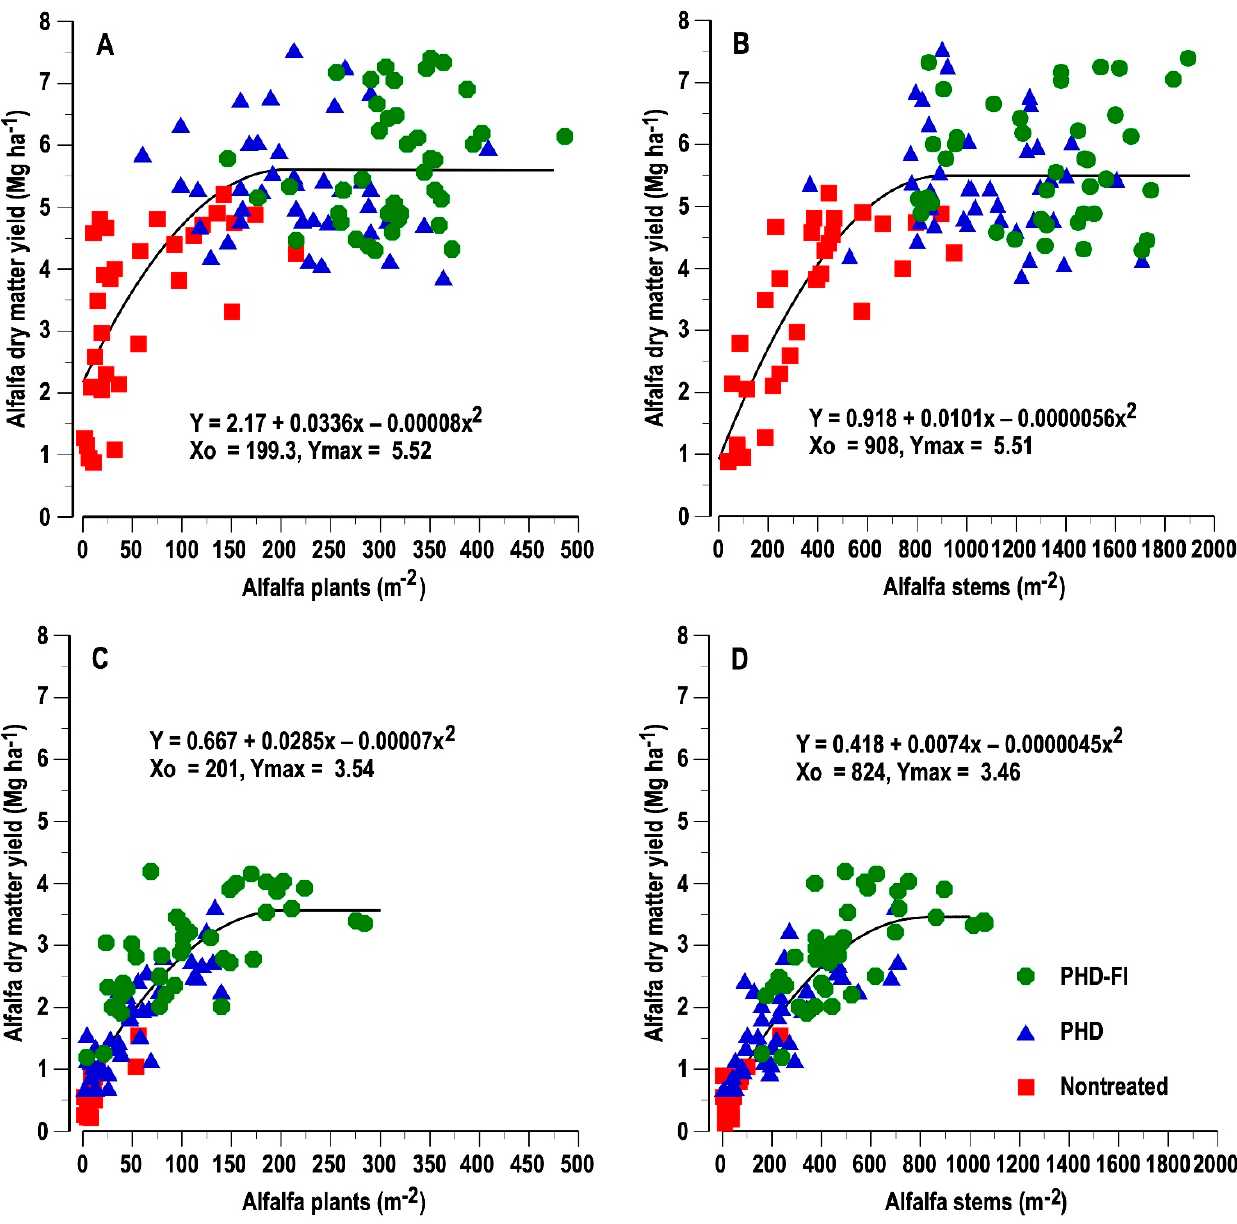
Figure 8. Relationship of first-cut dry-matter yield vs. plant or stem density of alfalfa interseeded into corn during 2017 and harvested in 2018 ( A , B ) and interseeded into corn in 2018 and harvested in 2019 ( C , D ). Agrichemical treatments applied during alfalfa establishment included a nontreated control, prohexadione (PHD), and prohexadione, followed by fungicide and insecticide (PHD-FI). Regressions were significant at p < 0.001.